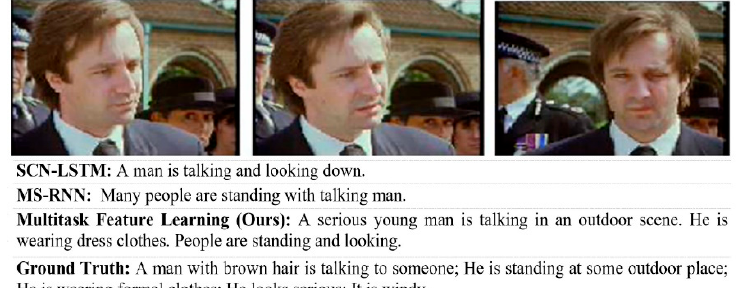
Figure 2. Face close-up video.